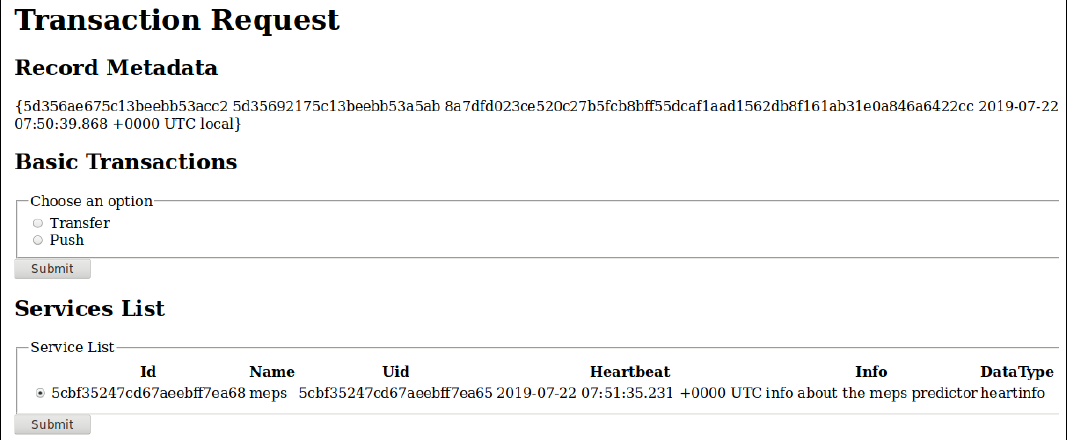
Figure 5. The UI used by the patient to initiate a transaction or invoke a service.